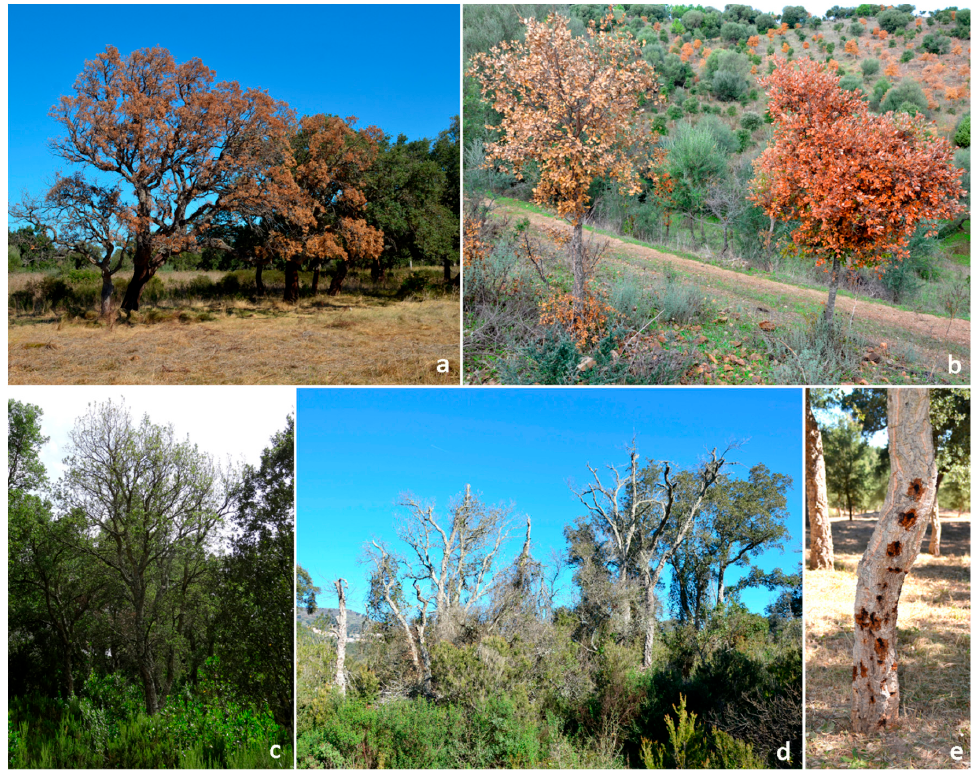
Figure 2. Symptoms caused by Phytophthora species on Quercus suber. ( a ) The sudden death of mature trees; ( b ) severe dieback and mortality of trees in 10-year-old afforestation; ( c ) trees showing a chronic decline with increasing transparency and wilting on the crown; ( d ) widespread dead and declining trees in a natural stand; ( e ) bleeding cankers at the stem base of a young tree.